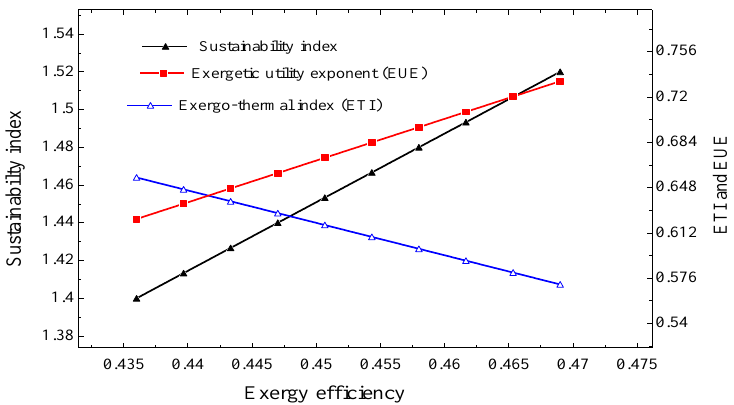
Figure 5. E ff ect of T pz / T 0 ratio on formation rates of NOx and CO. Figure 5. Effect of 𝑇 𝑝𝑧 𝑇 0 ⁄ ratio on formation rates of NOx and CO.